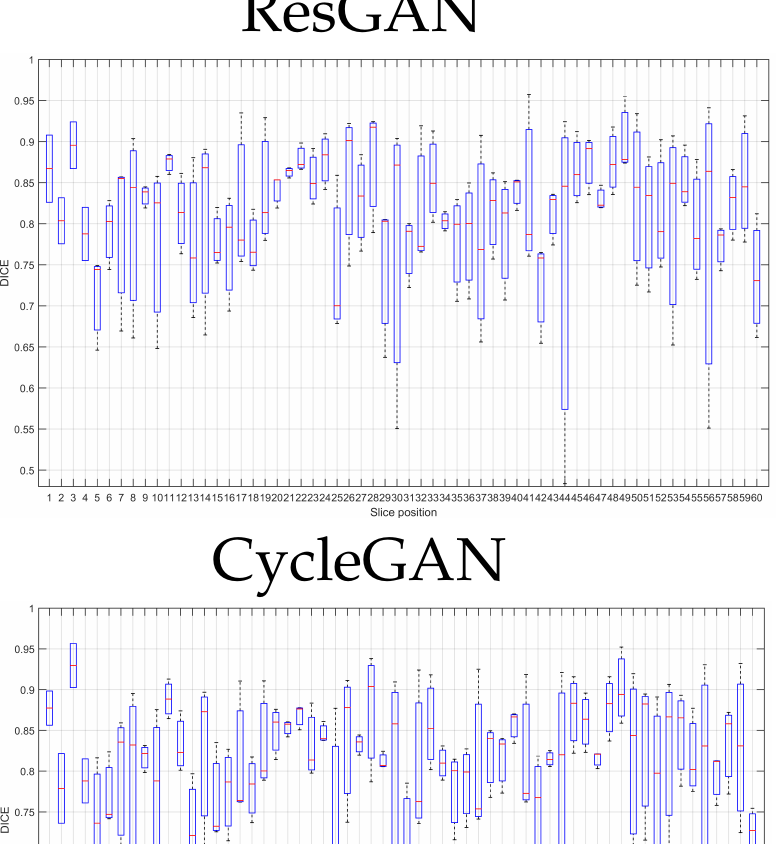
test set DICE results by slice position. Figure 10. Segmentation